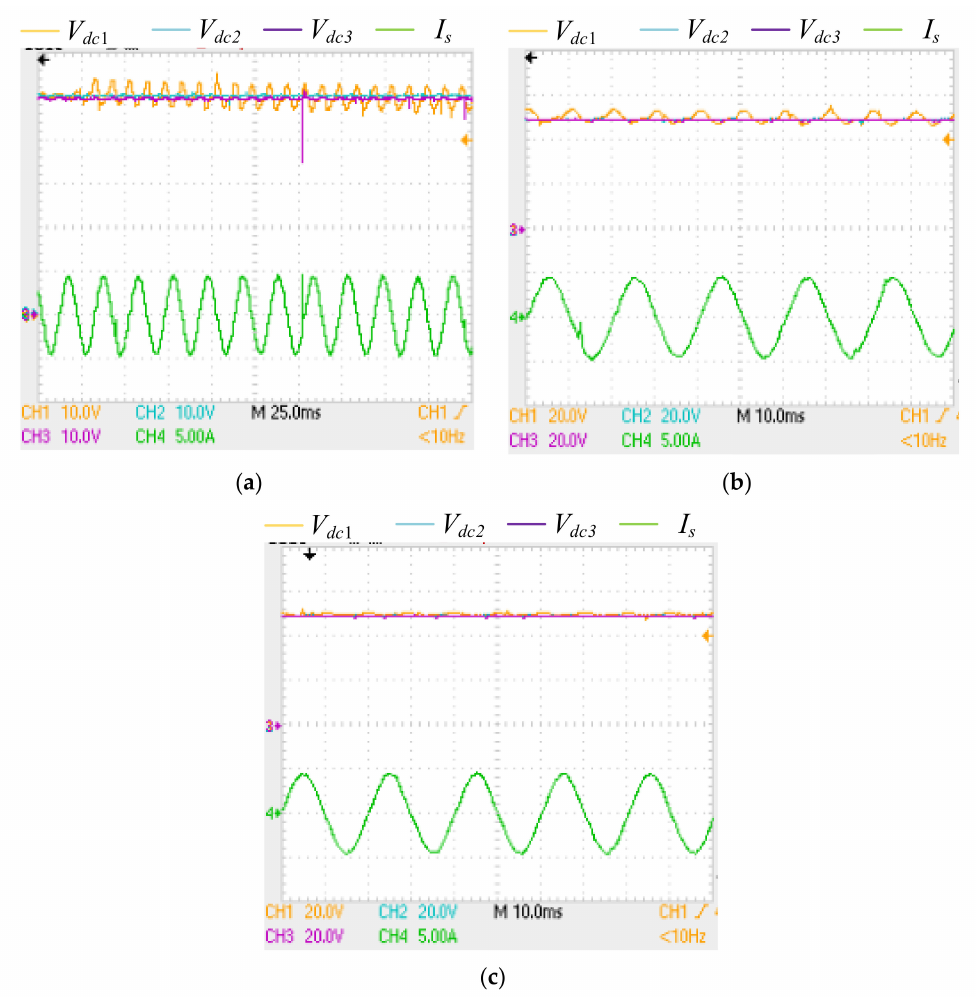
Figure 15. DC-side voltages and AC-side current under di ff erent modulation index. ( a ) m = 0.82; ( b ) m = 0.8; ( c ) m =